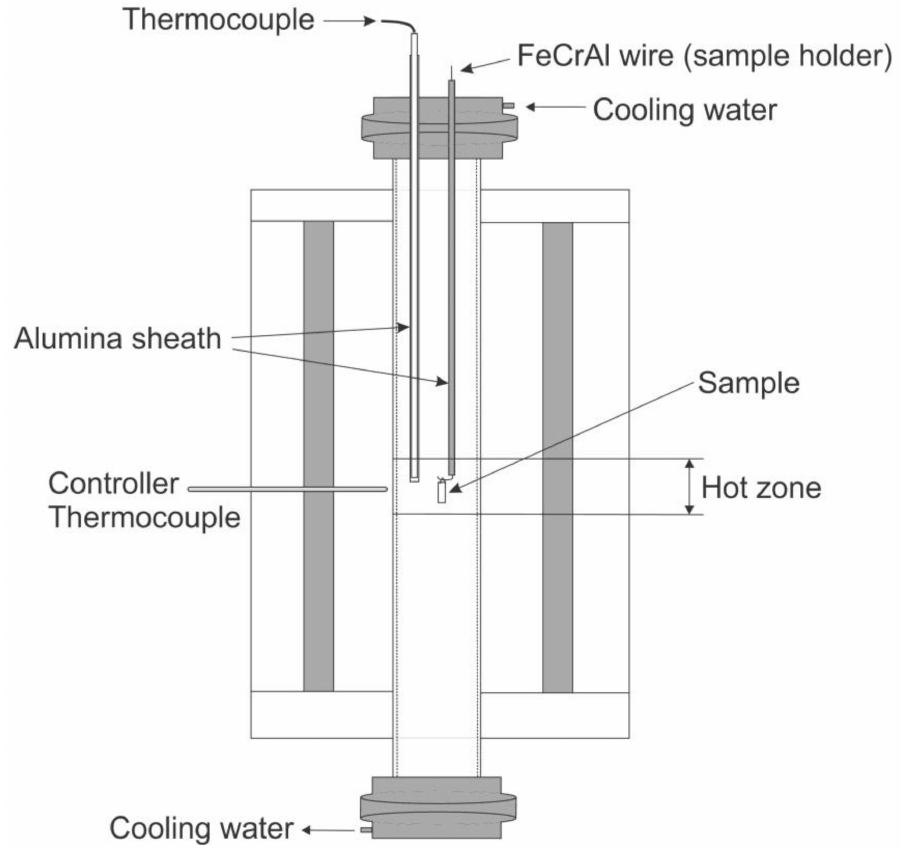
Figure 1. A schematic view of the experimental